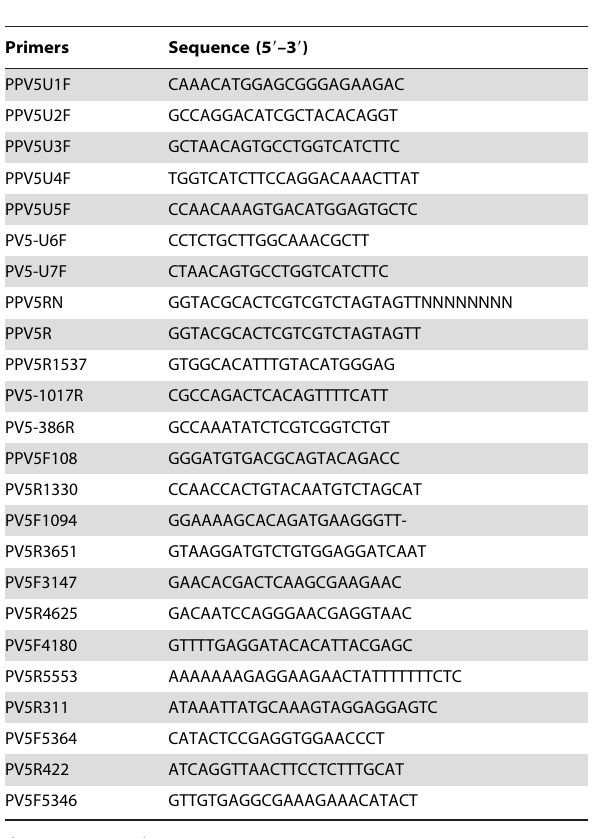
Table 4. Primers used for the PPV5 genome sequencing.